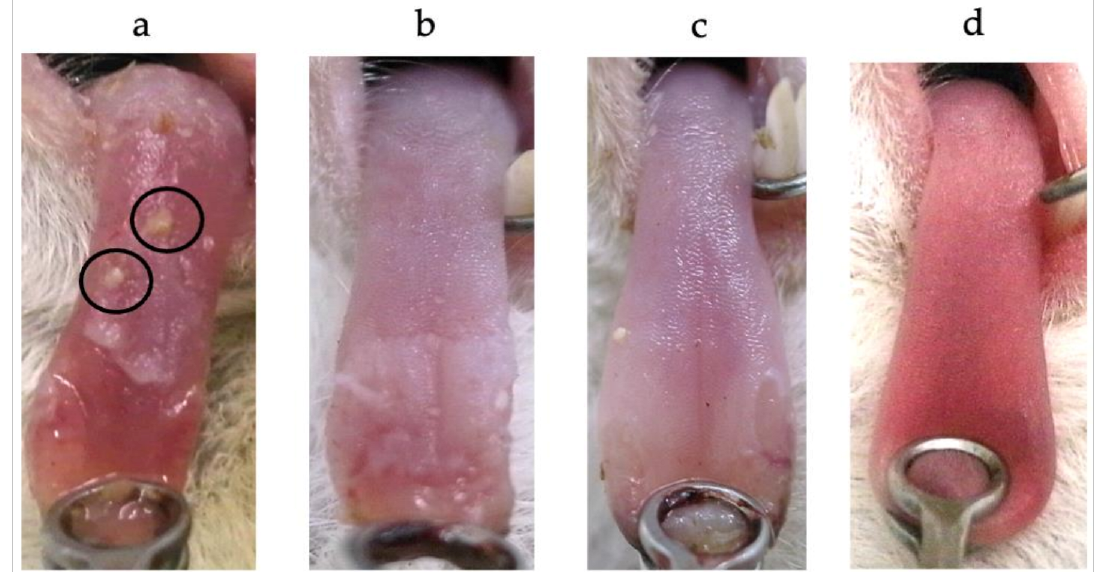
Figure 2. Macroscopic pictures of the tongue. ( a ) Group A: The presence of clinical oral candidiasis and food residue (circle). ( b ) Group B: A decrease in white patches on the tongue was observed compared to Group A. ( c ) Group C: The oral mucositis was decreased as compared to Group A and Group B. ( d ) Group D: The tongue of the negative control group.